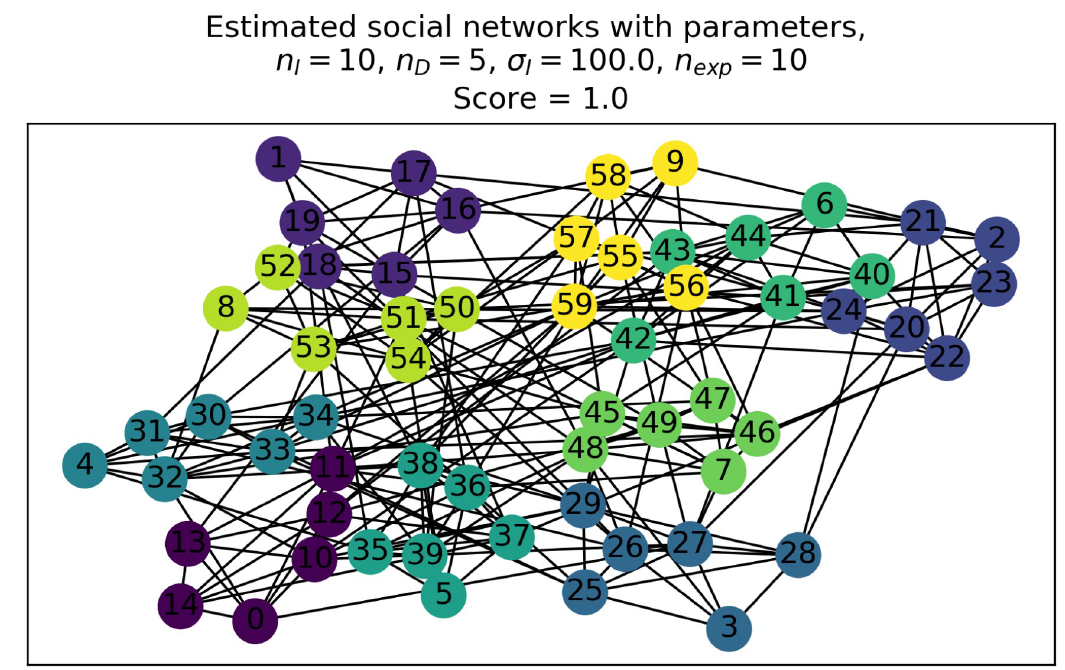
Fig 2. Example of the agent spatial distribution generated with model parameters, n I = 10, n D = 5, σ I = 100.0.